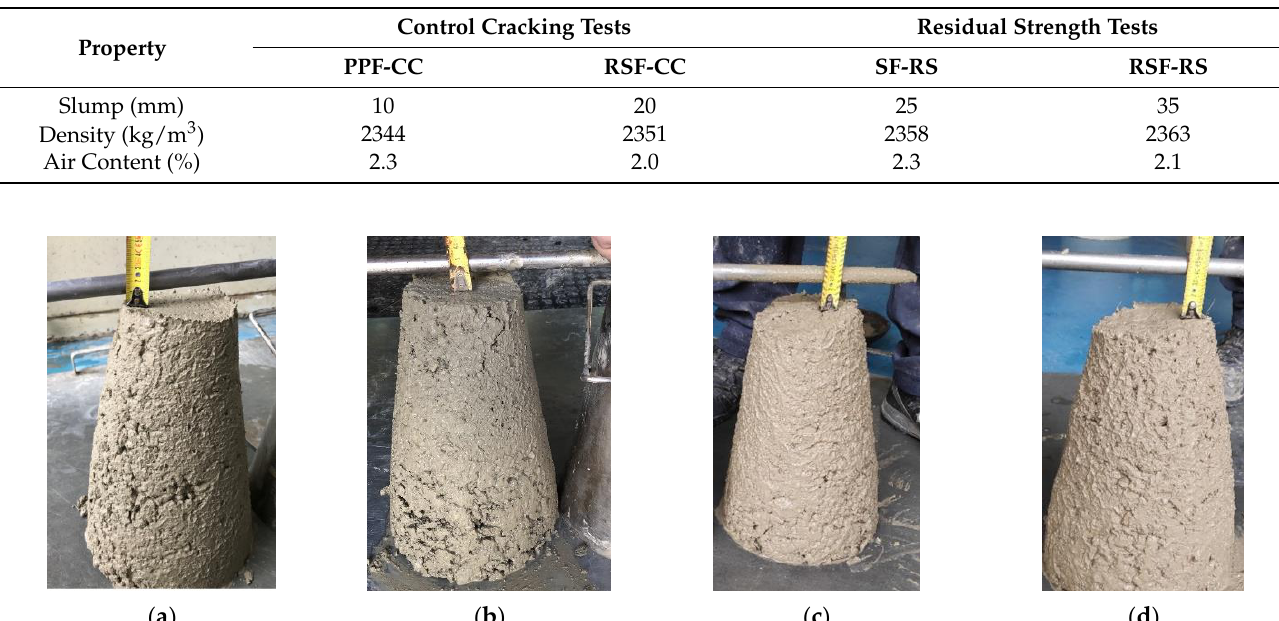
Figure 9. Slump-test cones from EN 12350-2 [51] test method: PPF-CC ( a ), RSF-CC ( b ), SF-RS ( c ), and RSF-RS ( d ). (Pictures by authors).